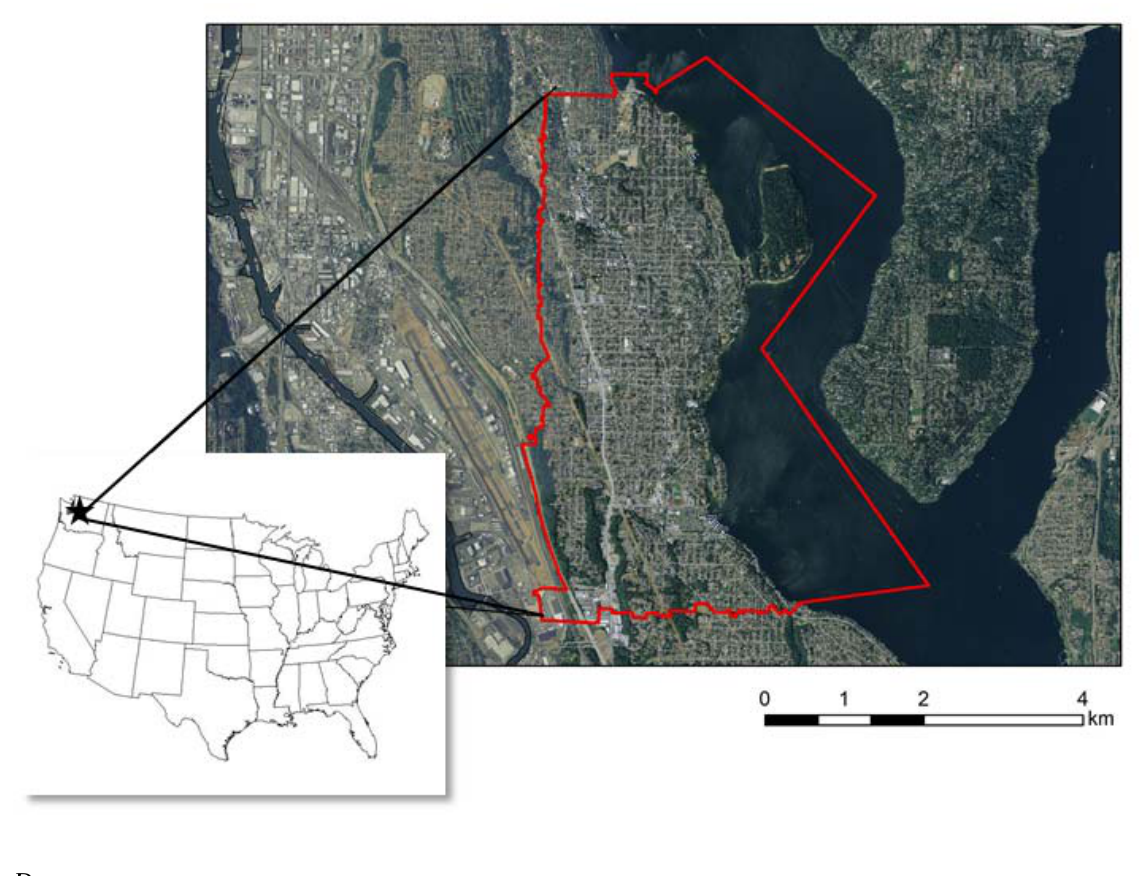
Figure 1. Map of study area showing Rainier Valley zipcode